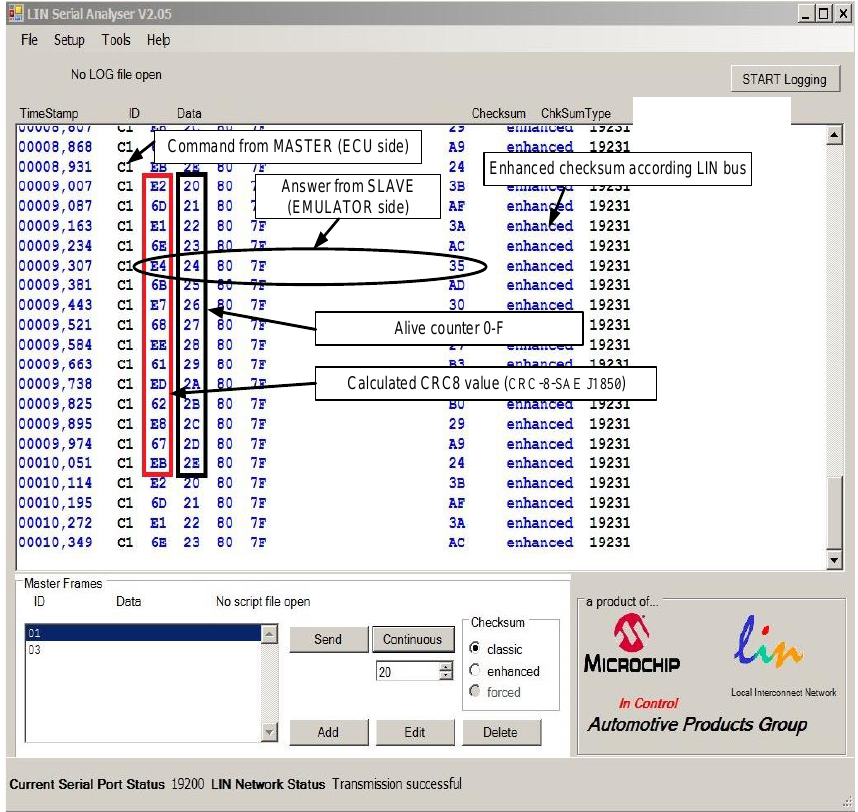
Figure 7 LIN bus communication frames between ECU side (MASTER) and LIN EPB switch emulator